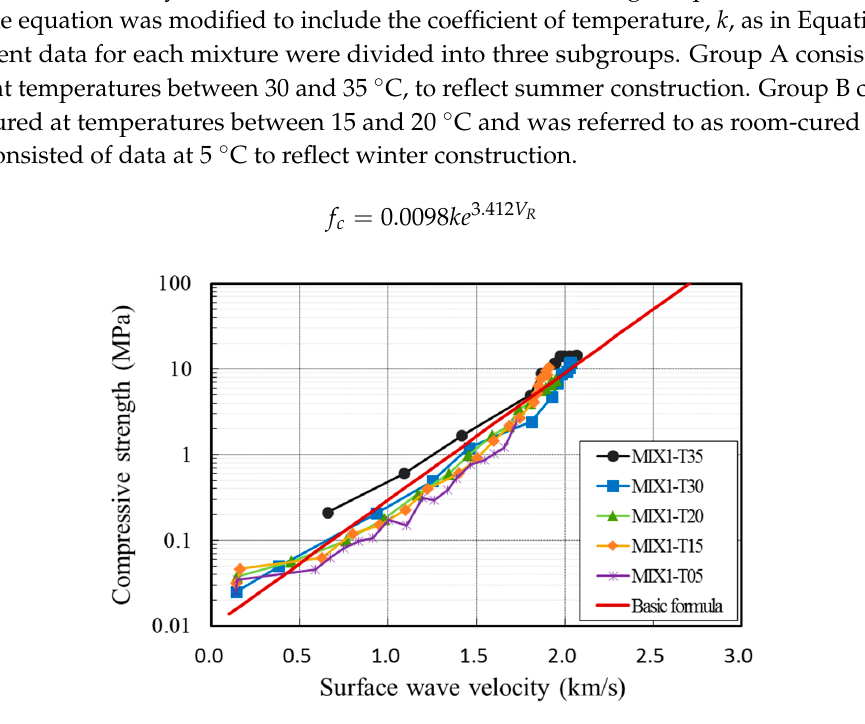
Figure 13. Relationship between the proposed formula and measurement data at different curing temperatures (MIX1).